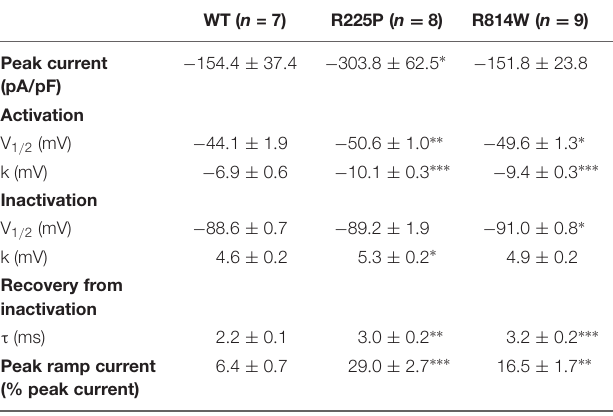
TABLE 1 | Biophysical parameters of Na v 1.5/WT, R225P, and R814W.